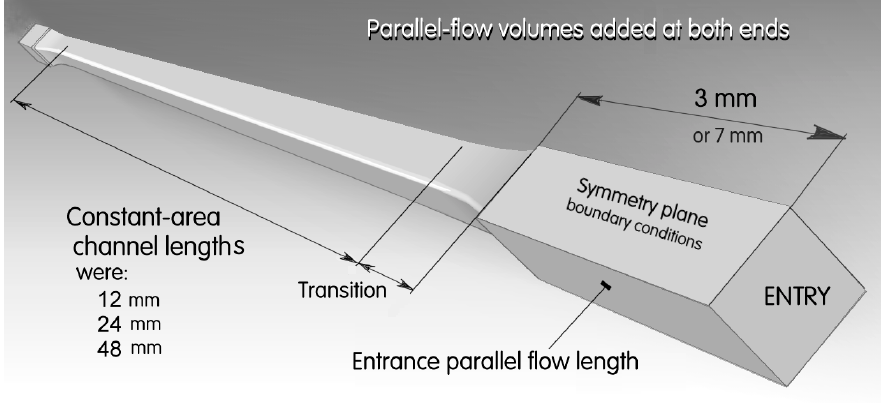
Figure 9. Perspective view of the computation domain—one quarter is a single passage (shaded in the end view presented in Figure 2).